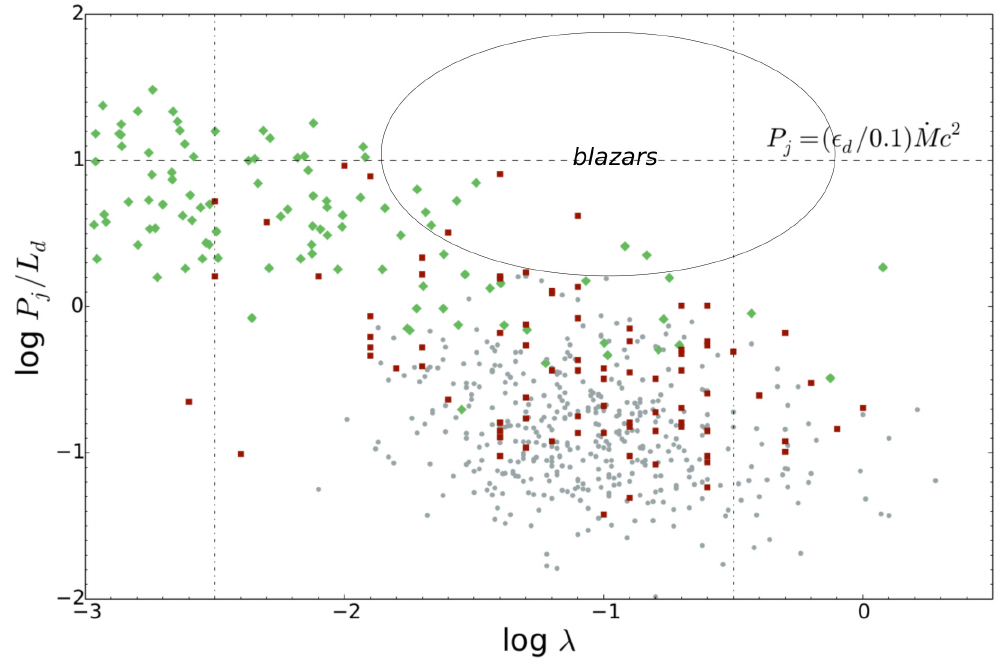
Figure 1. P j / L d ratio as a function of Eddington ratio λ Edd ≡ L d / L Edd . Green diamonds—FRII Narrow-Line-Radio-Galaxies [5]; red squares—Broad-Line-Radio-Galaxies plus radio-loud quasars [20]; grey dots—FRII quasars [24]; and the ellipse marks the approximate location of γ -ray selected FSRQs assumed to have jets with zero pair content [2]. The vertical dashed lines mark the range of the Eddington ratio within which the standard accretion disks are predicted to be radiatively efficient and geometrically thin. (The figure is adopted from Rusinek et al. 2016, in preparation